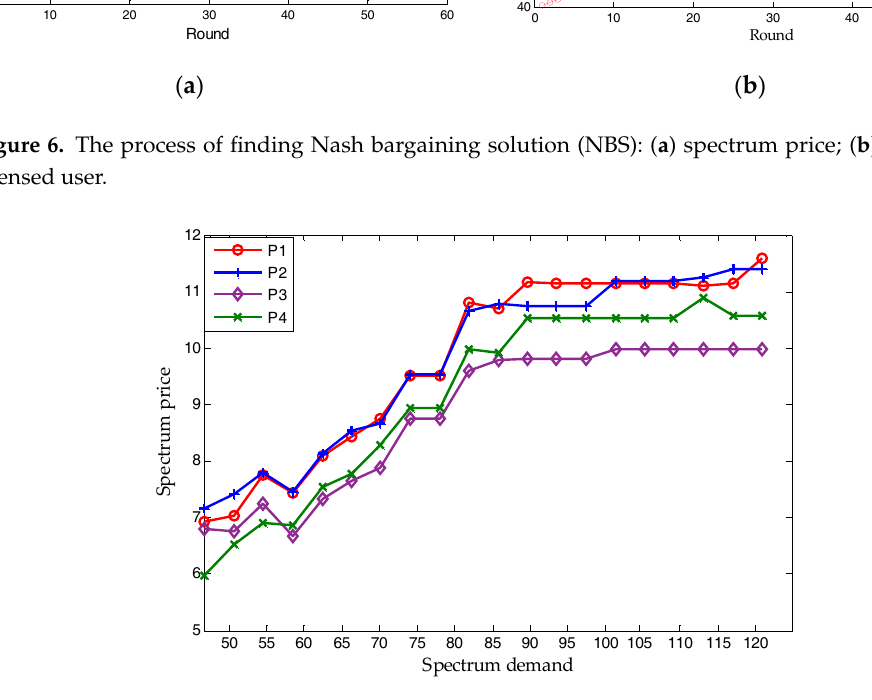
Figure 7. The relationship between NBS (spectrum price) and spectrum demand.